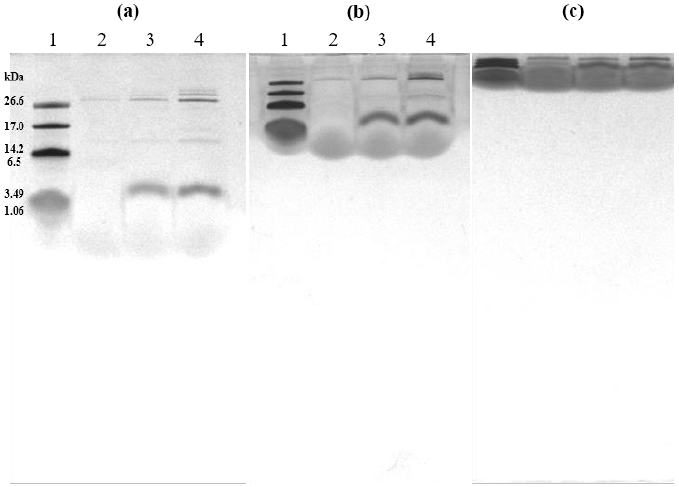
Figure 3. SDS-PAGE gel after final semi-preparative HPLC purification of tIK peptides. ( a ) A percentage of 16.5 SDS-PAGE gel run at half of the gel matrix length, ( b ) 16.5% SDS-PAGE gel run at 1/4 of the length, and ( c ) 18% SDS-PAGE gel at run 1/16 of the length. The tIK-9mer was only observed in ( c ) around 3.49 and 1.06 kDa. Lane 1: molecular weight marker; lane 2: tIK-9mer; lane 3: tIK-14mer; lane 4: tIK-18mer.